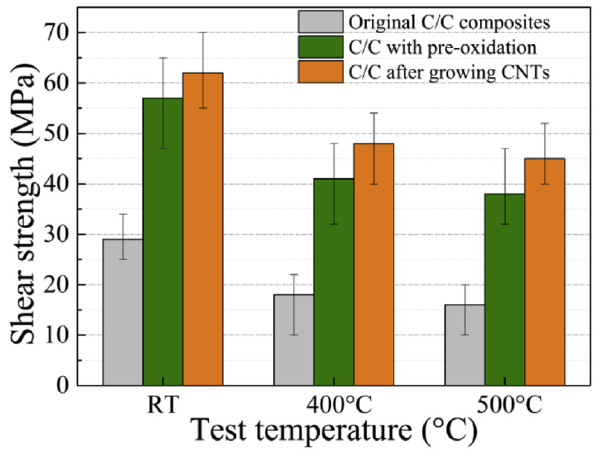
Figure 7: Shear strength of Nb-C/C joint brazed at 880 ∘ C for 10 min under different surface modification conditions of C/C composites at different test temperatures.